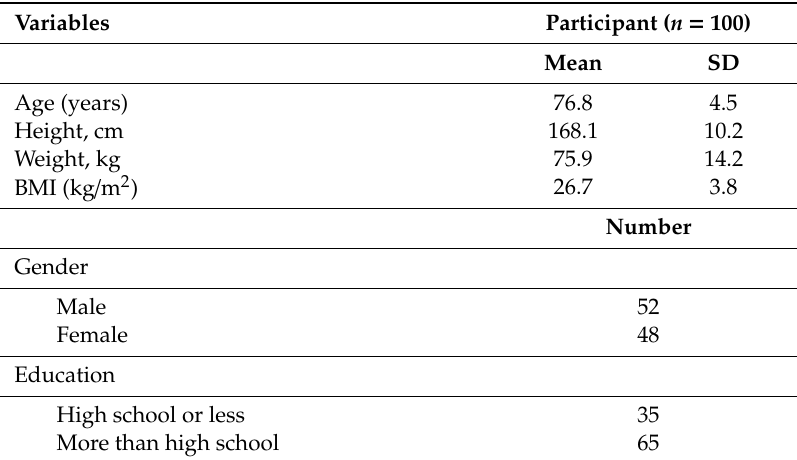
Table 1. Characteristics of study